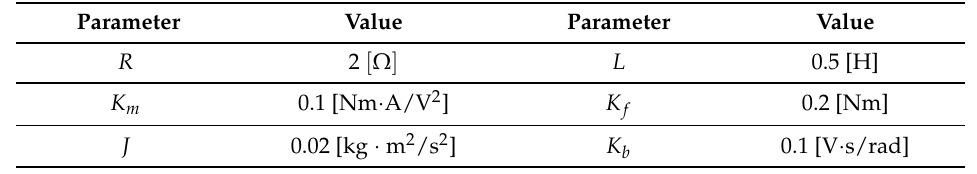
Table 5. DC motor physical parameters.